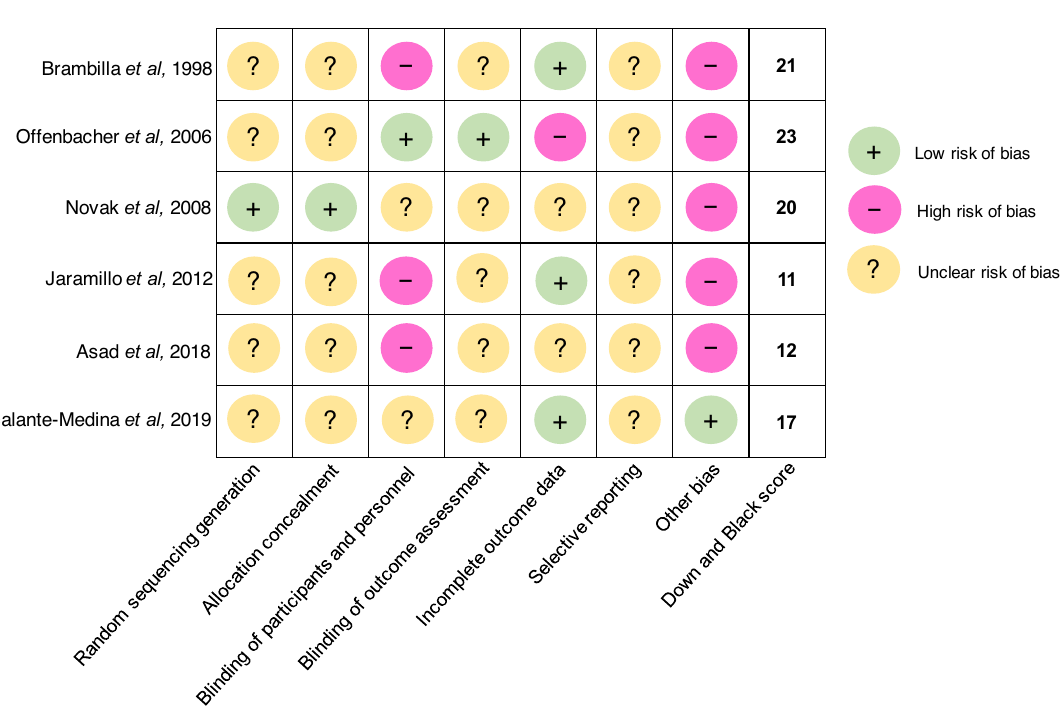
Figure 2. Summary of quality and risk of bias assessment using the Cochrane Collaboration’s tool for assessing risk of bias in randomized trials and the adapted Downs and Black scoring